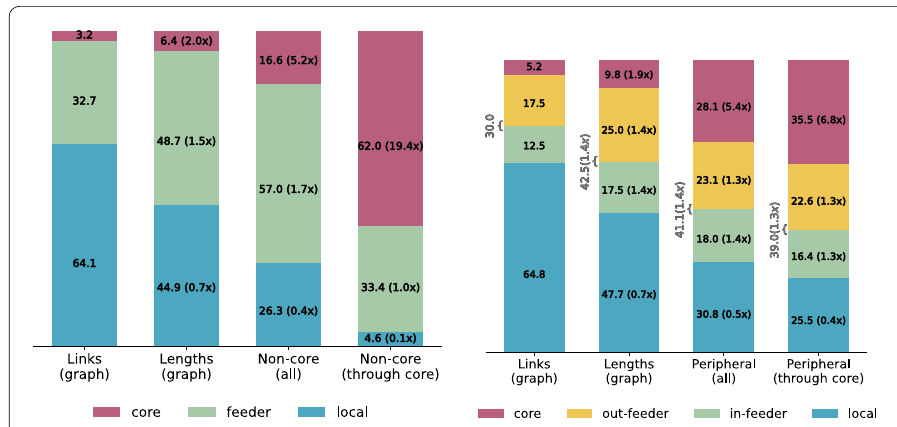
Figure 8 Percentage of edges and shipping length (real shipping distance between ports, measured in kilometers) by edge type in the original work (left) and with our updated minimum-route paths filtered with distance threshold α = 1.15 (right). The role of the core was simultaneously underestimated for all shortest paths between peripheral ports and overestimated for only paths between peripheral ports that pass through at least 1 core edge. The first bar in each plot shows the percentage of edges in the graph that fall into each category (sum of in and out feeders in gray to the left of each bar in the right plot). The second bar shows the percentage of total shipping length for edges in each category in the graph. The numbers in parentheses are the length percentage divided by the edge percentage. The majority of edges in both representations are local (64.1% and 64.8%), but local edges make up relatively less of the total length among all edges in the graphs. The third bar in each plot shows the percentage of length by category for all paths between peripheral ports (75% of shortest paths in the previous analysis vs. 26% here), while the fourth bar shows the same quantity but only for paths that pass through at least 1 core edge (25% previously vs. 74% here). Using shortest paths through the undirected co-route graph we find that the role of the core was under-estimated for all paths (16.6% vs. 24.2%). However, the length-to-edge percentage ratios are similar for all